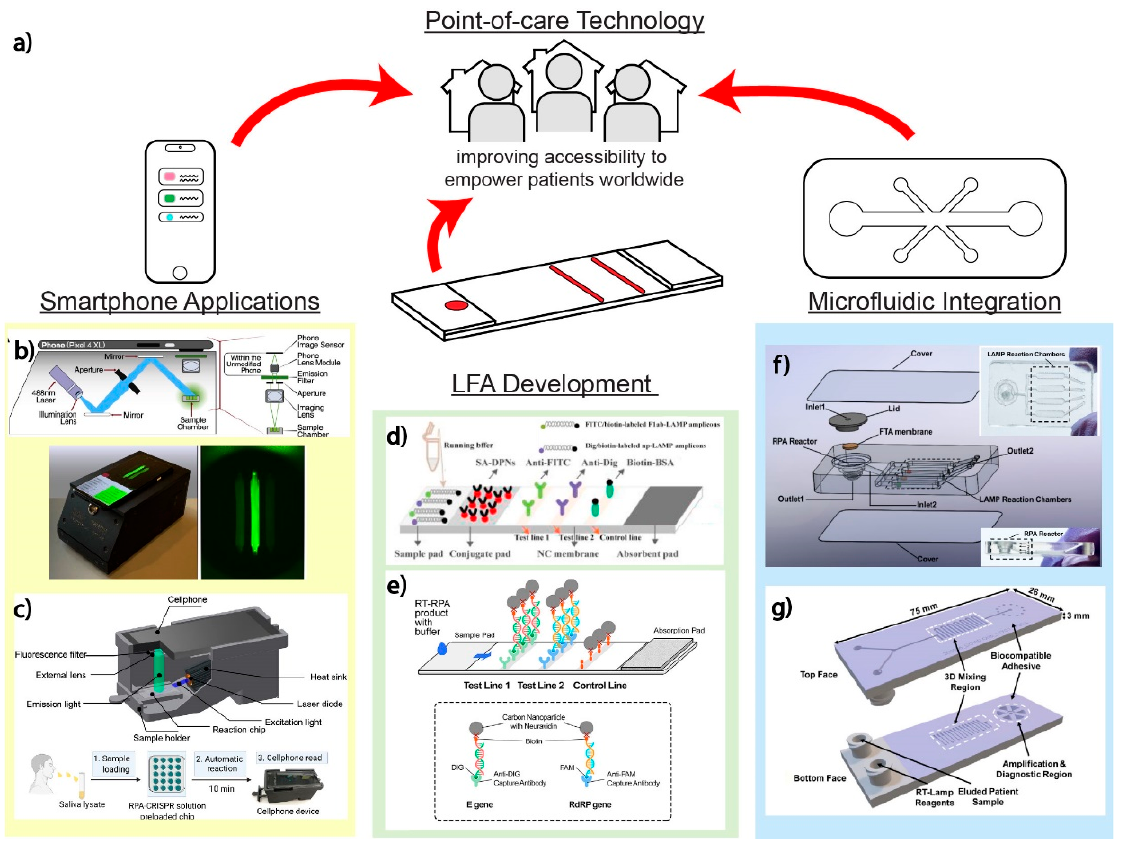
Figure 6. Point-of-care technologies. ( a ) POCT for improving diagnostic testing accessibility to medical deserts, especially in lower income communities around the world. The use of smartphone technology, microfluidic integration, and/or continued LFA development is pertinent to empowering individuals without high-resource clinicians and hospitals nearby. ( b ) Smartphone-based detection for amplification-free detection of SARS-CoV-2 with CRISPR-Cas13a. Adapted with permission from Ref. [12]. Copyright 2021, Elsevier. ( c ) Smartphone-based detection of VOCs by PAM-targeting mutations. Adapted with permission from Ref. [118]. ( d ) Lateral flow assay using nanoparticles. Adapted with permission from Ref. [107]. Copyright 2020, Elsevier. ( e ) Lateral flow assay with RPA for low resource setting. Adapted with permission from Ref. [69]. Copyright 2021, Elsevier. ( f ) 3D-printed integrated microfluidic chip for colorimetric detection. Adapted with permission from Ref. [117]. Copyright 2021, Elsevier. ( g ) Microfluidic chip with LAMP-based portable assay. Adapted with permission from Ref. [120]. Copyright 2020, the Authors.